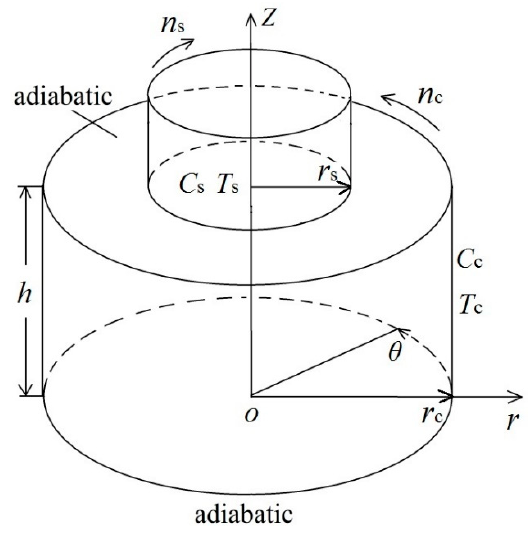
Figure 1. Physical model and the coordinate system.